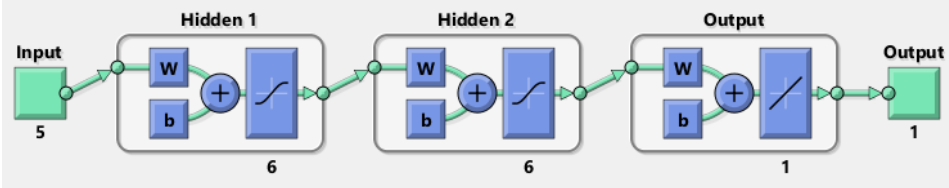
Figure 7. The architecture of ANN in MATLAB.